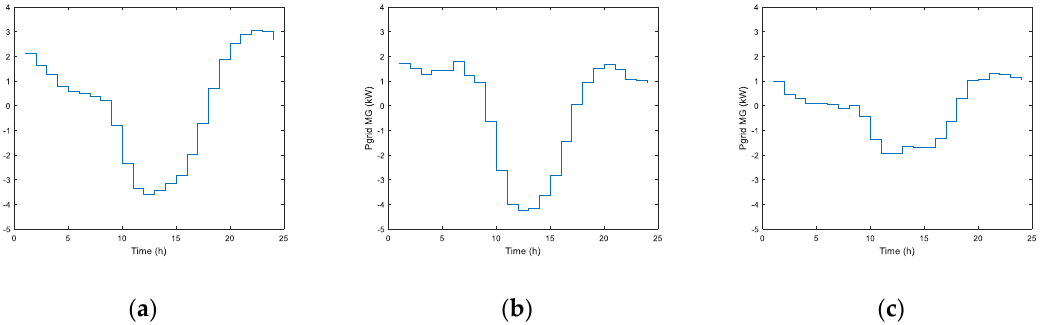
Figure 11. P grid during scheduled 24 h (positive values for export energy flow and negative for import), in the new case study: ( a ) Without ESS; ( b ) COF; ( c ) MOF.